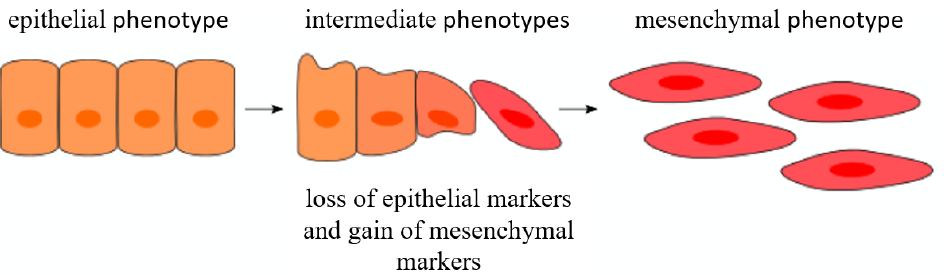
Figure 1. The process of epithelial–mesenchymal transition. A layer of polarized epithelial cells transitions toward a mesenchymal state. The cells with intermediate phenotype have transitioned into a partial EMT state and express both epithelial and mesenchymal markers (adapted from [10]).